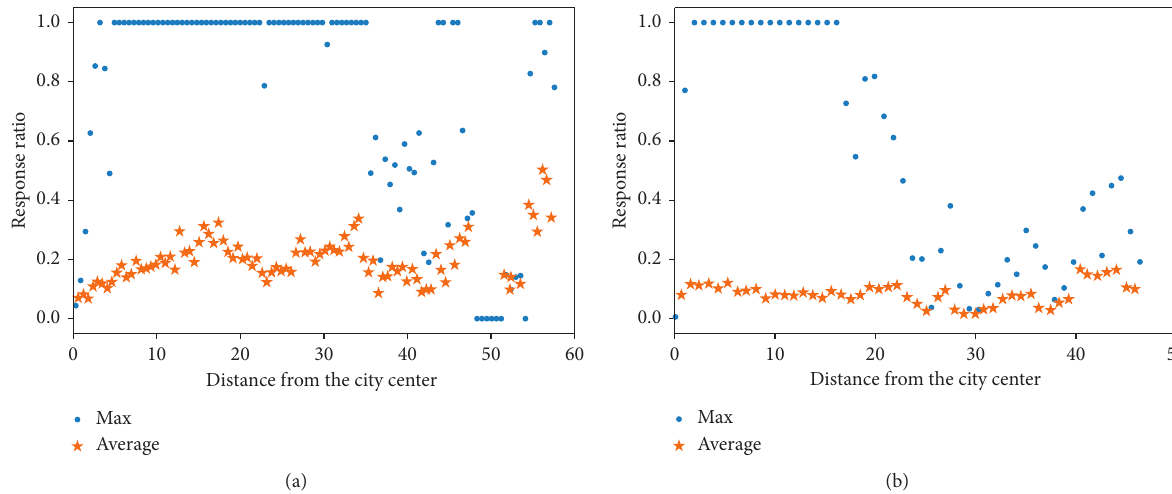
Figure 6: The matching degree varies with the distance from the city center. (a) Beijing. (b) Shanghai. The blue dots are the maximum matching degree and the orange stars are average matching degree. The X -axis represents the distance of taxis supply points from the city center. The Y -axis represents the matching degree of taxi resources.